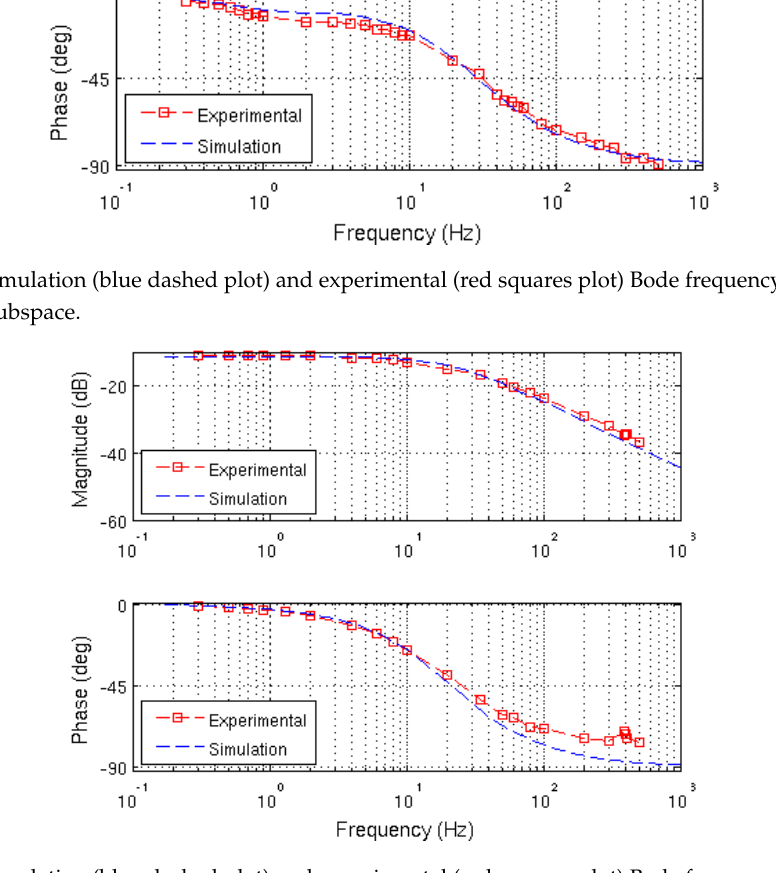
Figure 7. Simulation (blue dashed plot) and experimental (red squares plot) Bode frequency responses in the x–y subspace.